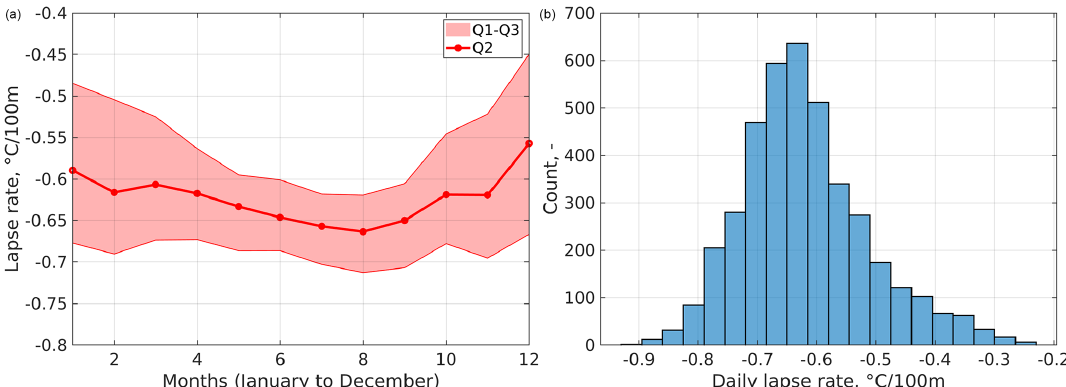
Figure 3. Daily national lapse rate climatology (a) and frequency distribution of daily national lapse rates according to S3M Italy for the period September 2010–August 2021. Q1, Q2, and Q3 are the first, second, and third quartiles of the daily national lapse rates for each